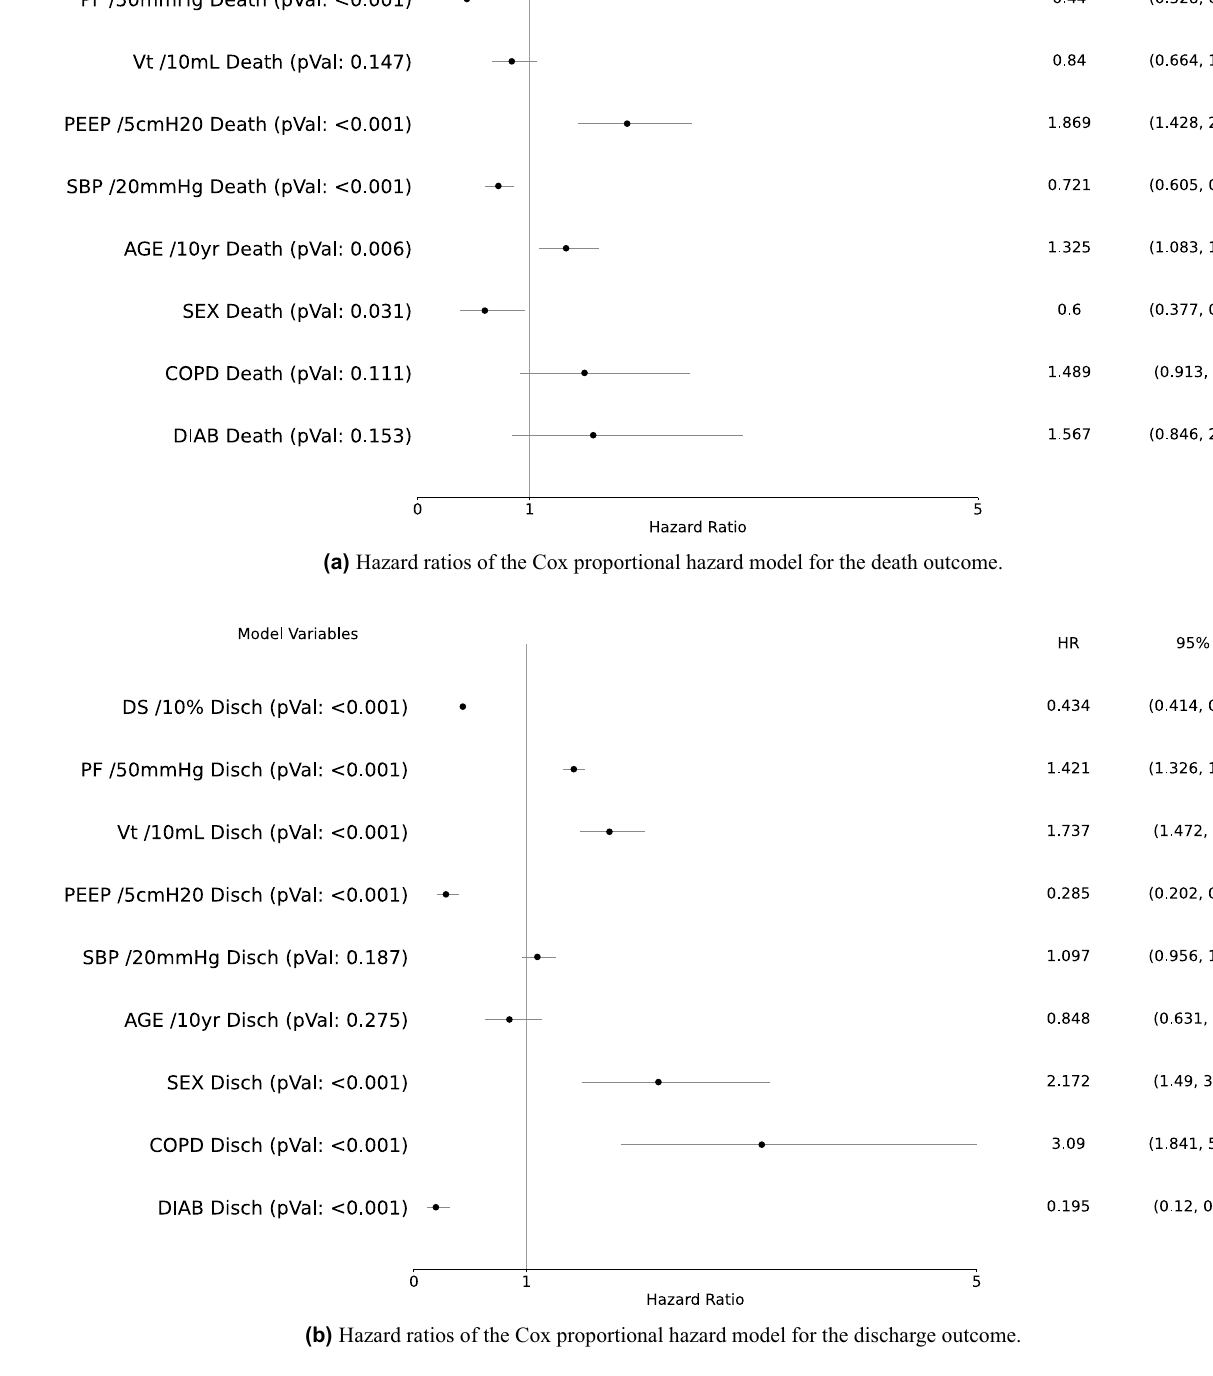
Figure 2. Hazard ratios (HR), confidence intervals (CI) and p values for each increment of selected variables with respect to the death ( a ) and the discharge ( b ) outcome at 7 days since the last available set of physiological data. Numbers alongside each continuous variable indicate the scaling factors for computing hazard ratios. AGE age in years, COPD presence or absence of chronic obstructive pulmonary disease, DIAB presence or absence or diabetes mellitus, PEEP positive end-expiratory pressure, in cmH 2 O, PF ratio of arterial oxygen partial pressure (PaO 2 , in mmHg) to fractional inspired oxygen (FiO 2 ), SBP systolic blood pressure in mmHg, SEX patient’s sex (females = 1, males = 0), DS physiologic dead space estimated using the Enghoff’s modification of the Bohr’s Equation, Vt tidal volume, in